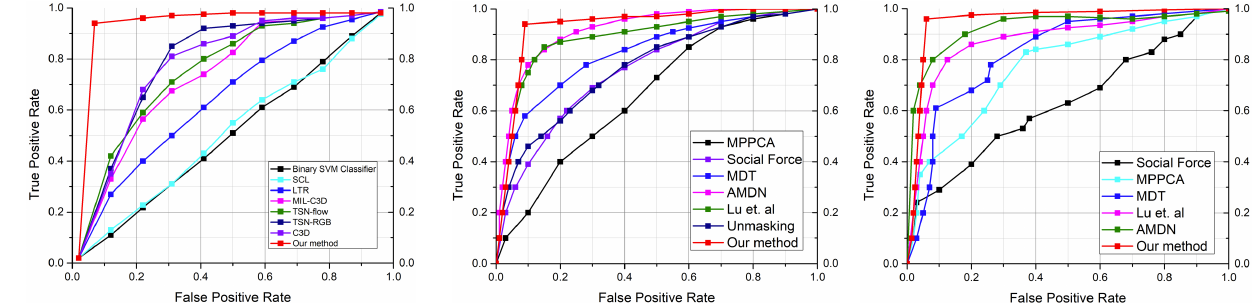
Figure 5. The proposed approach is compared to other existing approaches using the UCFcrime, UCSDped1, and UCSDped2 dataset. The ROC curves for state-of-the-art methods and our method are represented in the color codes.